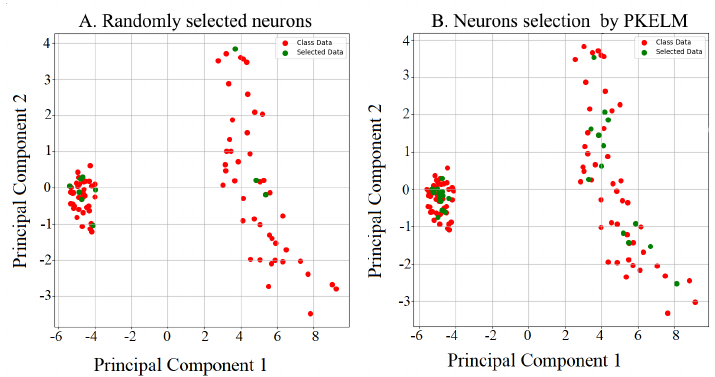
Figure 18. ( A ) Randomly selected neurons and ( B ) Neuron selection by using PKELM from the first two training sessions during incremental learning of Pakistani food